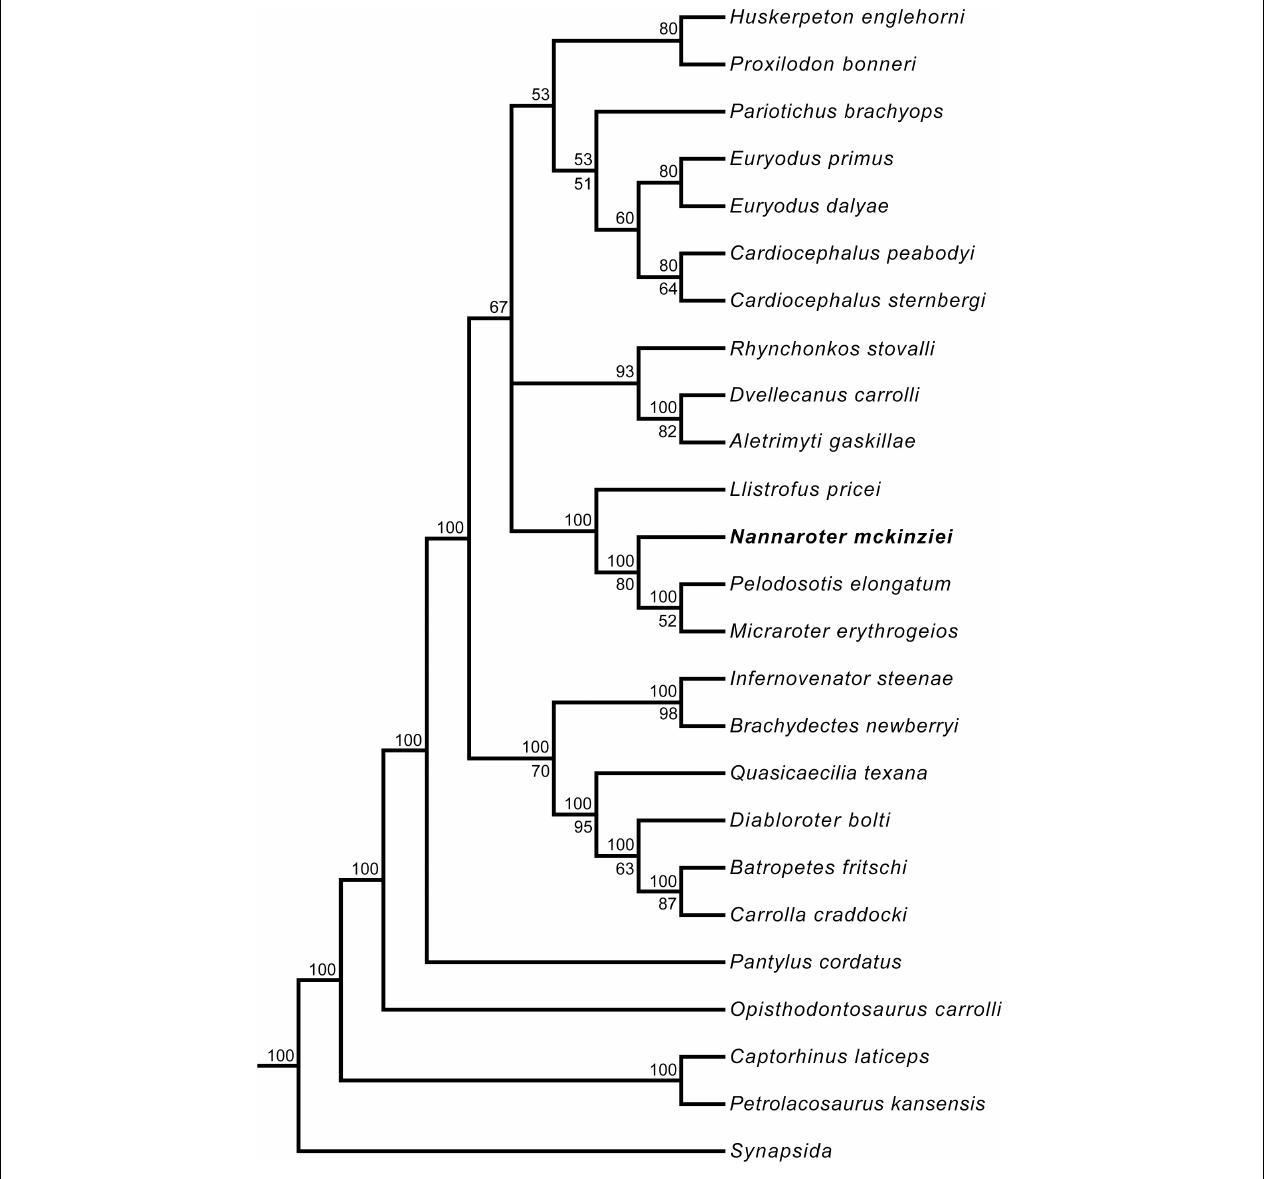
FIGURE 9 | Majority rule consensus tree of the 270 optimal trees obtained from the phylogenetic analysis. Tree length = 1,744, consistency index = 0.2683, rescaled consistency index = 0.1764, retention index = 0.6574. Numbers above nodes represent the frequency of nodes (%). Bootstrap values are found below nodes, if no value is indicated it was less than 50%. Taxa have been trimmed to concentrate on Recumbirostra, the clade of